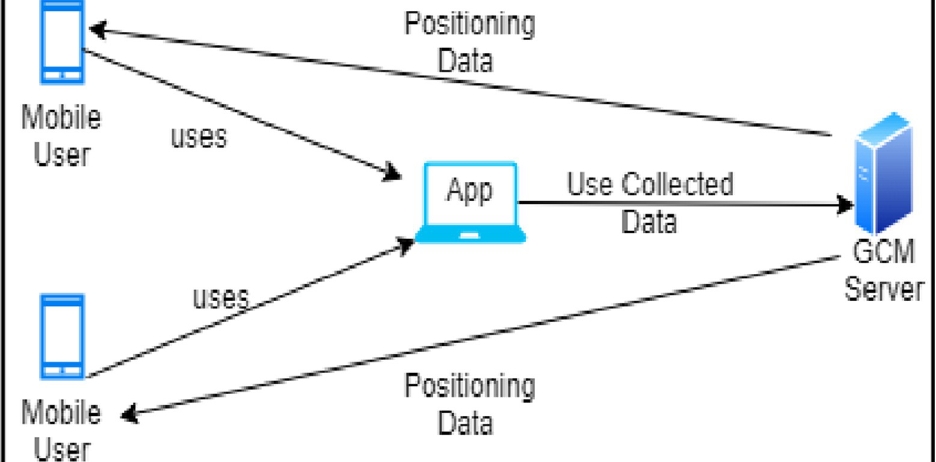
Fig 3. Android-based